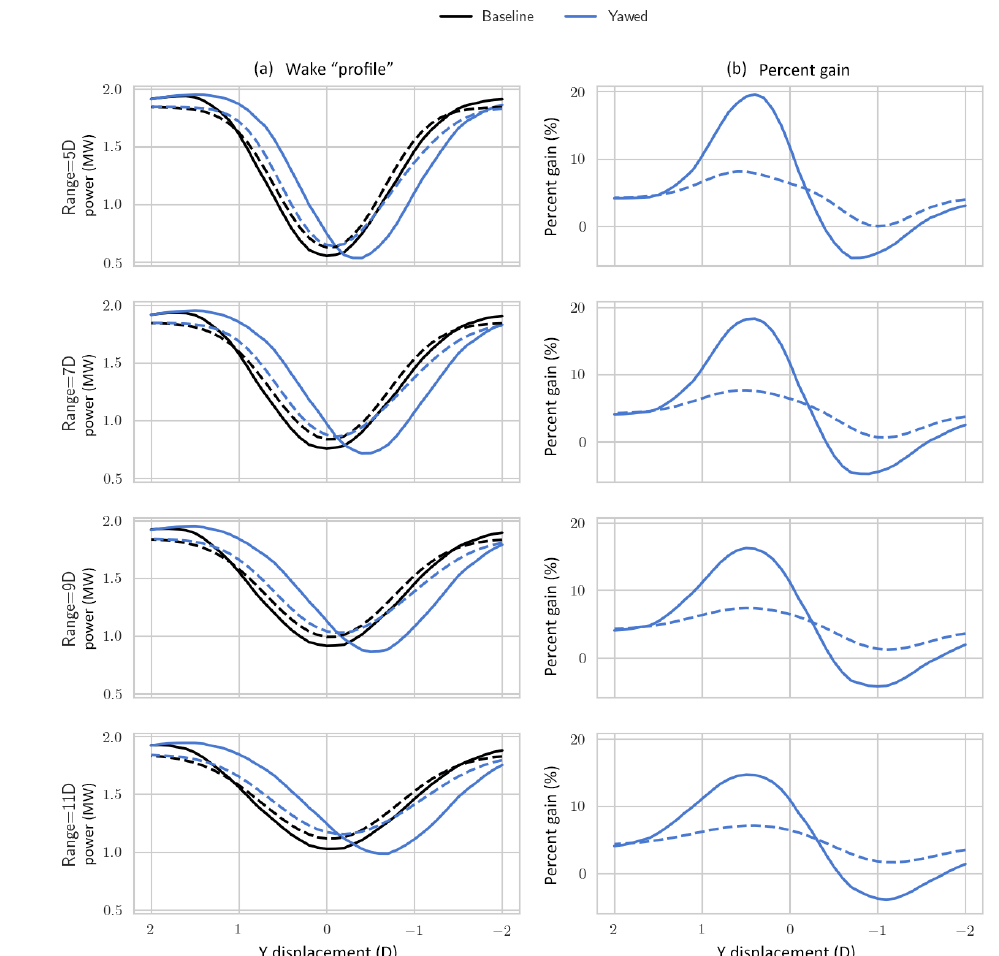
Figure 8. Power of a hypothetical turbine behind the second turbine in SOWFA (solid) and FLORIS (dashed) (a) and percent increase relative to baseline (b) . FLORIS has good agreement in the baseline case but misses the change in wake behavior obtained in the yawed case in